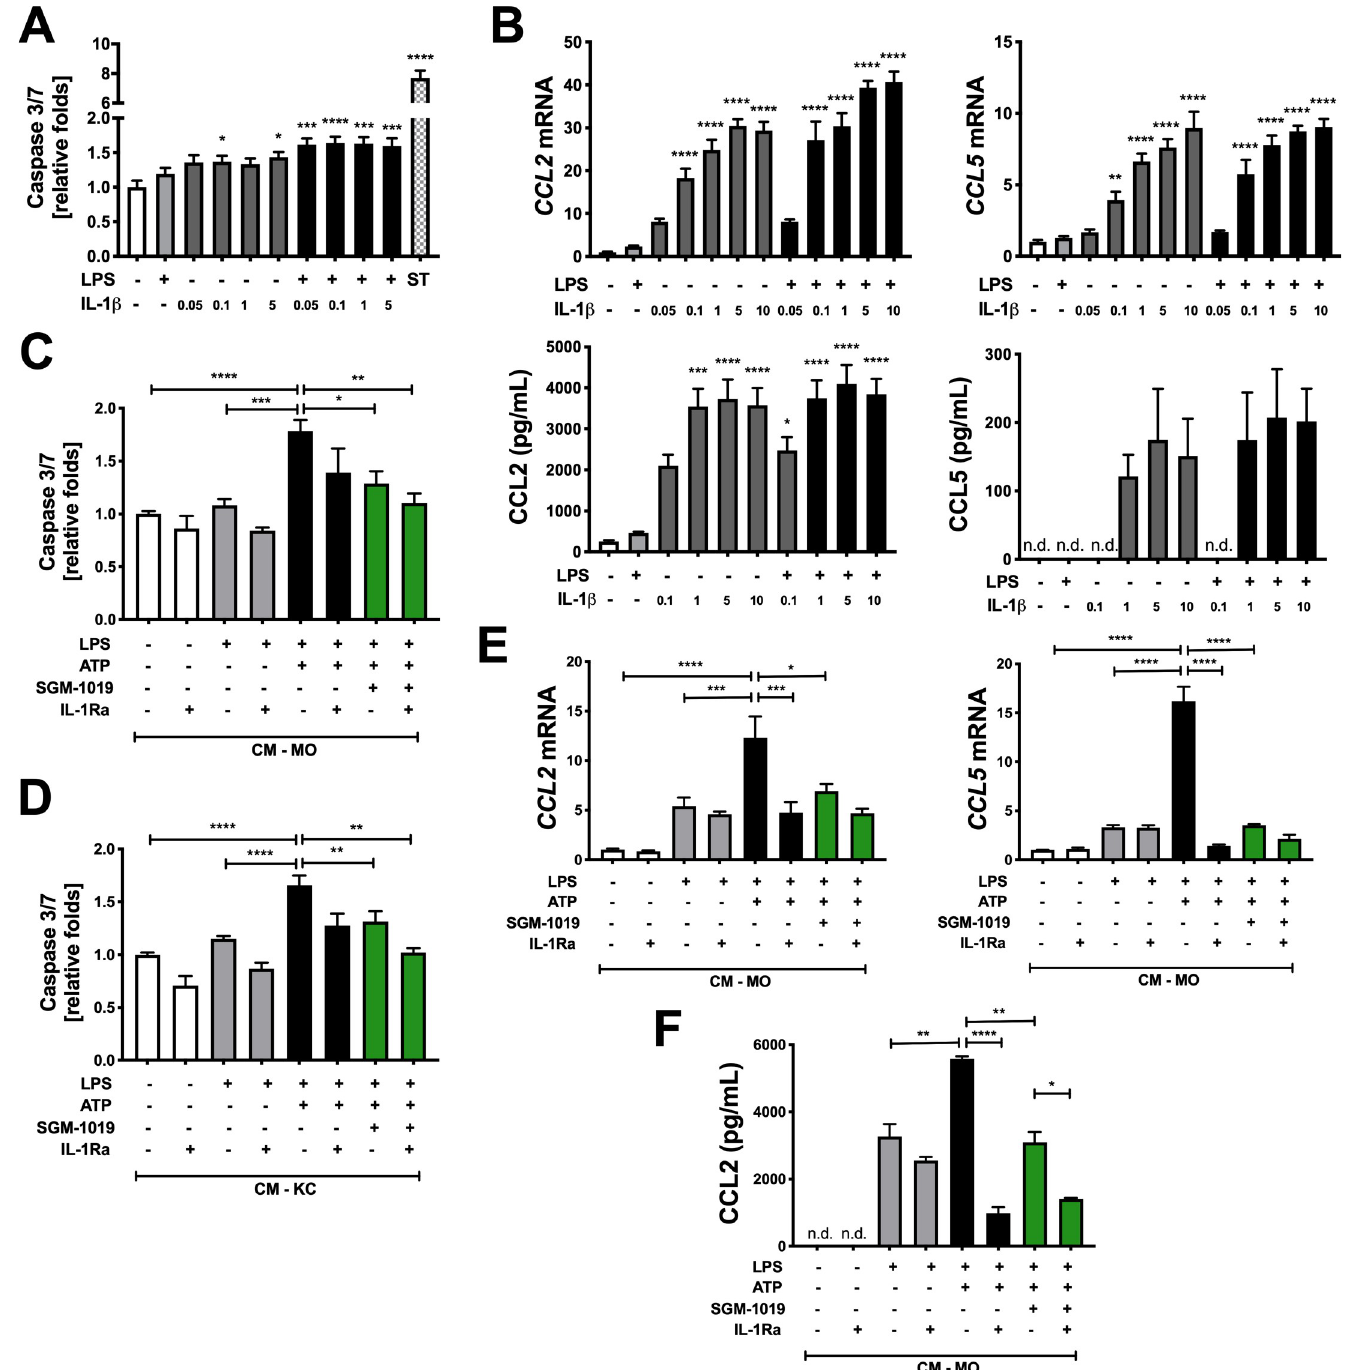
Fig 6. P2RX7-mediated IL-1 β modulates hepatocyte death and CCL2/CCL5 expression and secretion in hepatocytes. (A) Relative caspase 3/7 activity in human primary hepatocytes treated with LPS ± increasing concentrations (in ng/ml) of recombinant human IL-1 β (IL-1 β ). Staurosporine (ST) was used as a positive control. (B) Relative expression of CCL2 / CCL5 and CCL2/CCL5 levels in human primary hepatocytes treated with LPS ± increasing concentrations of IL-1 β . Relative caspase 3/ 7 activity in hepatocytes cultured with (C) CM-MO or (D) CM-KC treated with LPS, ATP ± SGM-1019 and/or IL-1Ra. (E) Relative expression of CCL2 / CCL5 and ( F ) CCL2 levels in human primary hepatocytes cultured with CM-MO treated with LPS, ATP ± SGM-1019 and/or IL-1Ra. n.d., for not detected. In all statistical plots, the data are shown as the mean ± SEM. � P � 0.05, �� P � 0.01, ��� P � 0.001, ���� P � 0.0001 by one-way ANOVA.